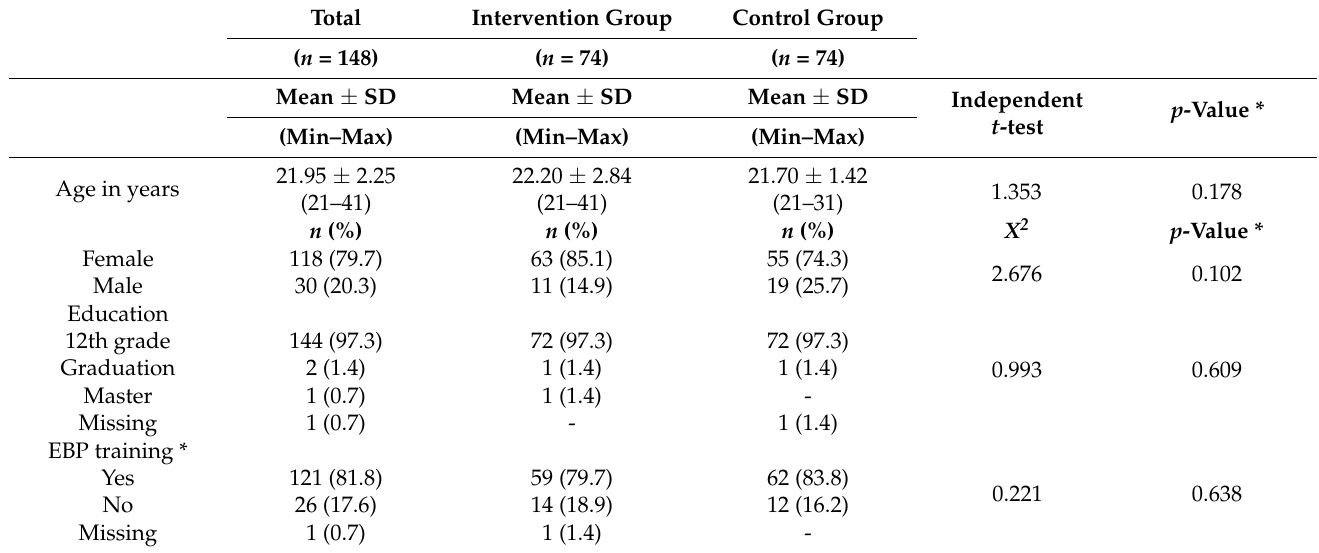
Table 1. Socio-demographic characterization of the sample—ITT analysis.